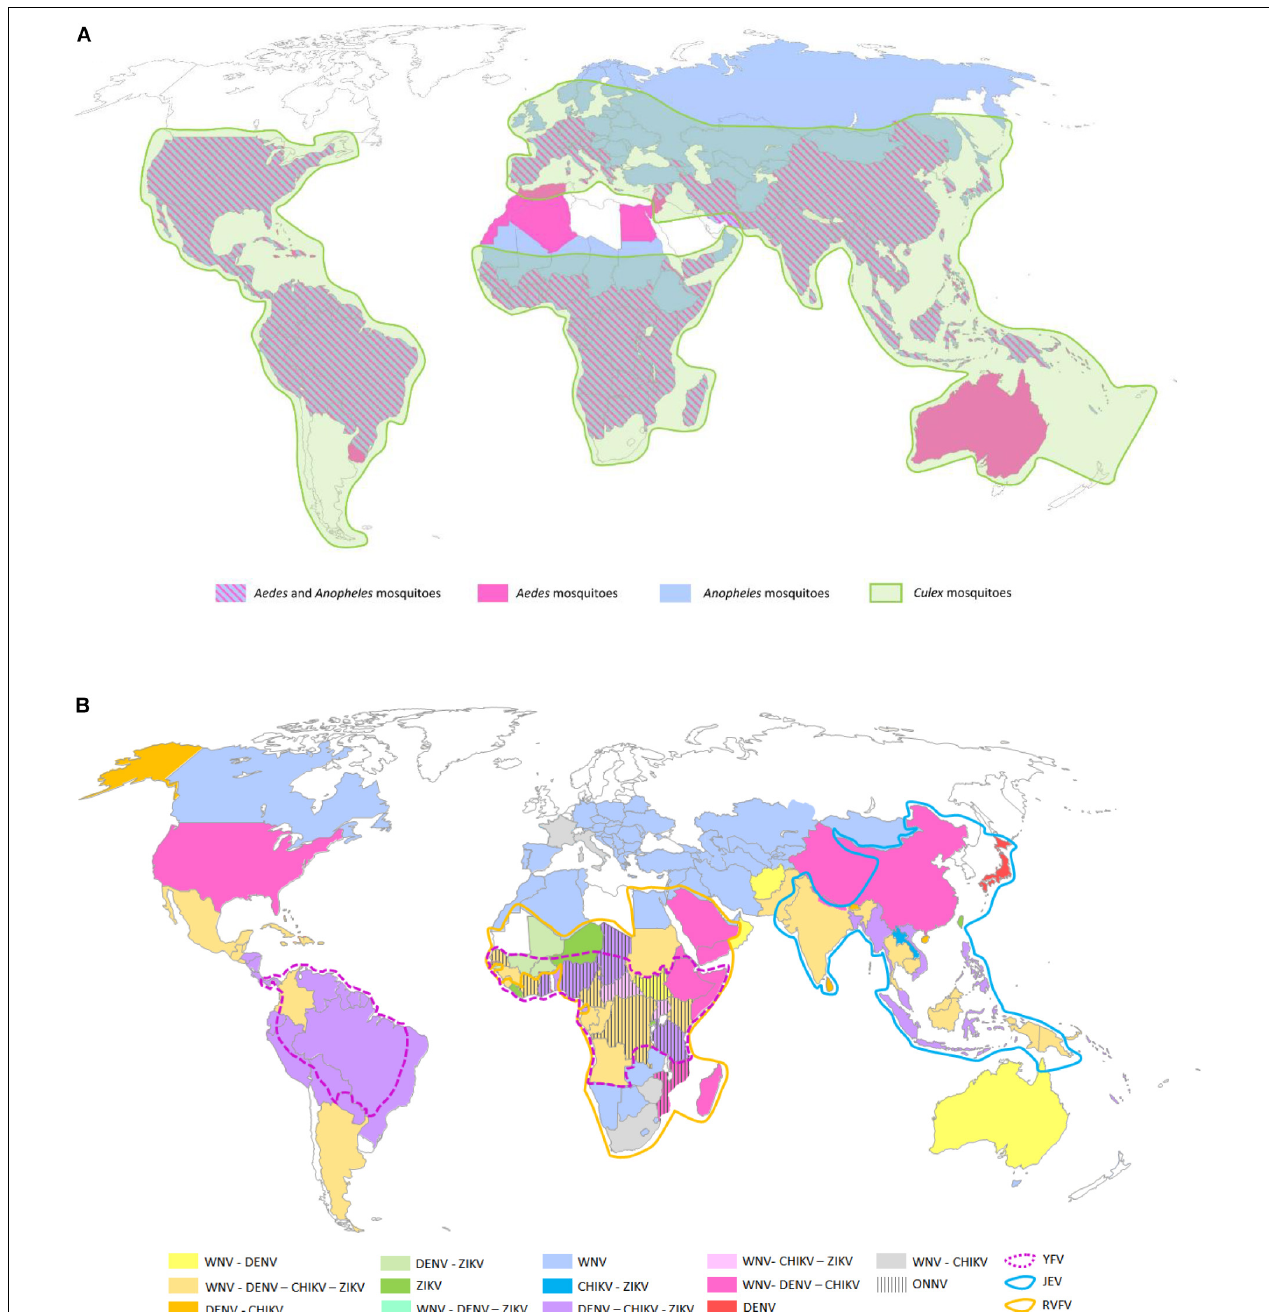
FIGURE 1 | Global distributions of mosquito genera of medical importance (A) and arboviruses transmitted by the three main mosquito genera (B) . (A) The three mosquito genera reported on the map are the most prevalent ones around the world representing the principal vectors of arboviruses ( Aedes and Culex spp.) and parasites ( Anopheles spp.) of human health importance. The pink, blue, and green areas represent respective presence of Aedes spp., Anopheles spp., and Culex spp. mosquitoes. The hatched areas represent the distribution of Aedes spp. and Anopheles spp. mosquitoes in the same countries. (B) Map of the main arboviruses transmitted by Aedes , Culex , and Anopheles spp. including the flaviviruses (YFV, JEV, DENV, ZIKV, and WNV), the alphaviruses chikungunya (CHIKV) and O’nyong’nyong virus (ONNV), and the phlebovirus Rift valley fever virus (RVFV) (Tiwari et al., 2012; Hanley et al., 2013; Reisen, 2013; Fredericks and Fernandez-Sesma, 2014; Houe et al., 2019; Noorbakhsh et al., 2019; Pezzi et al., 2019; Centers for Disease Control and Prevention, 2020a,c; European Centre for Disease Prevention and Control, 2021). The maps were built using the open source map site https://cmap.comersis.com/cartes-Monde-WORLD.html.